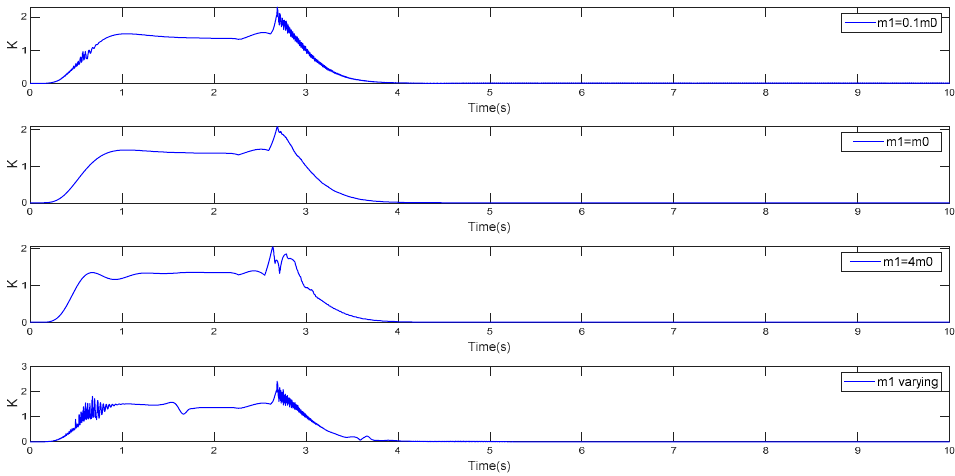
Figure 8. Tracking error trajectories of the flexible manipulator tip position with the tip mass varying.